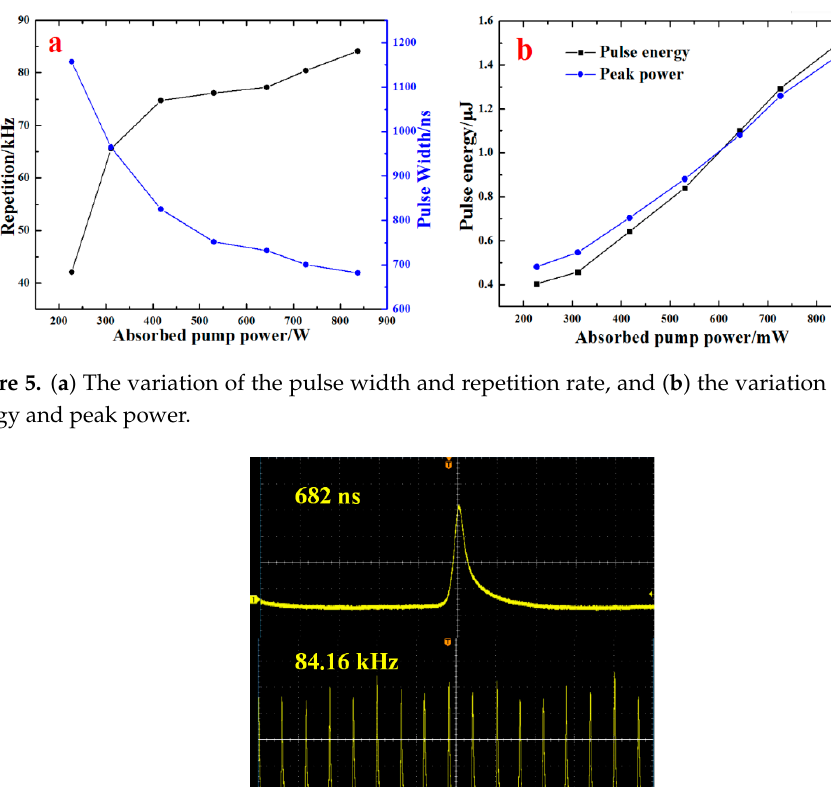
Figure 4. ( a ) Average output power properties for CW and Q-switched laser, ( b ) two-dimensional (2D) image of Q-switched output beam spatial profile, and ( c ) the laser spectrum at the maximum output power for Q-switching.